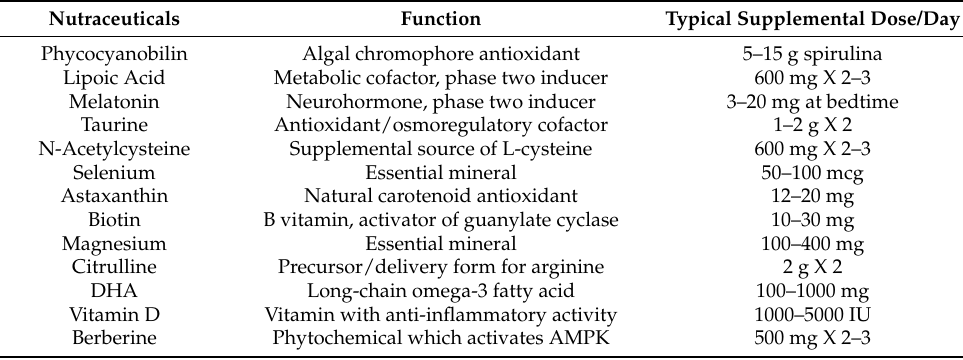
Table 1. Nutraceuticals with potential for prevention/control of Alzheimer’s